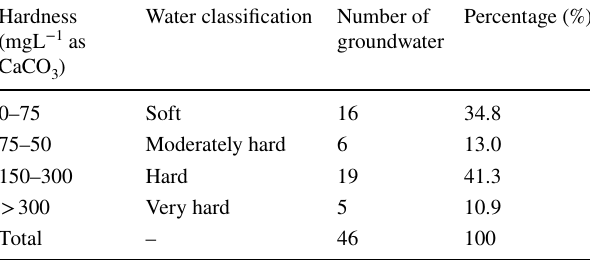
Table 2 Classification of groundwater based on hardness values